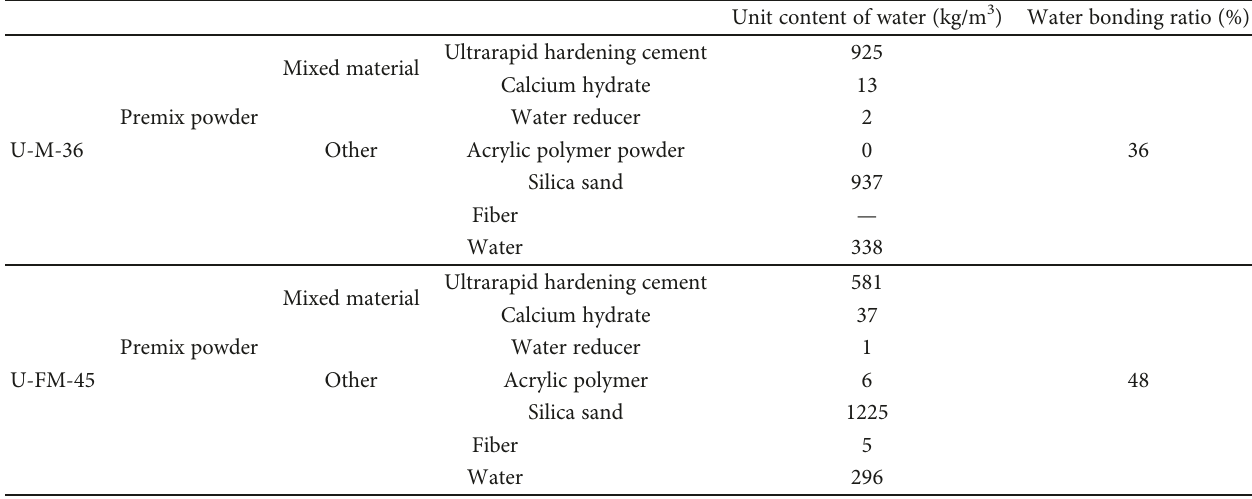
Table 1: Composition of repair